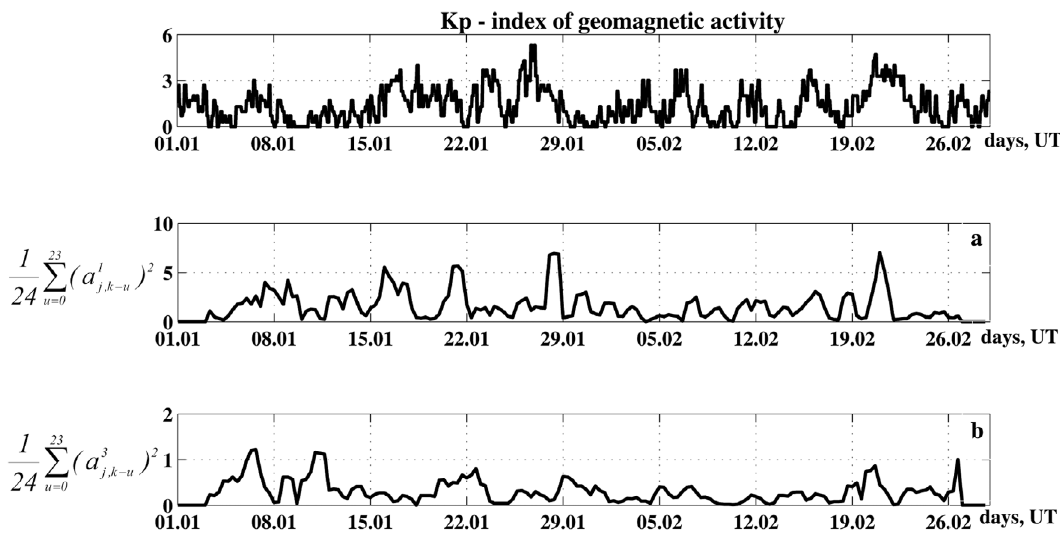
Figure 8. Simulation results for foF2 data from Kamchatka for the period 01.01.2006–26.02.2006. (a) Prediction error for the component f 2 -3 t in the sliding time window equal to 24 hours; (b) prediction error for the component g 2 -3 t in the sliding window equal to 24